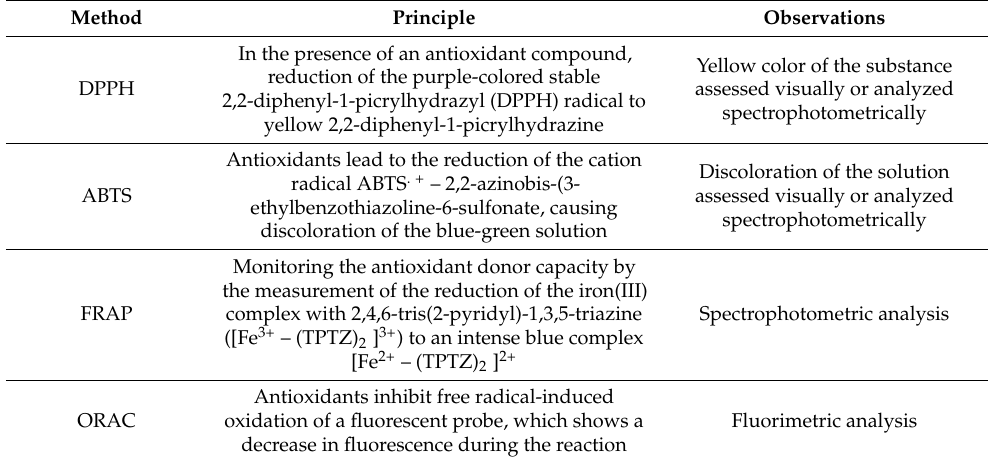
Table 2. Selected methods for the determination of antioxidant activity (own work based on: [121,122]). Method